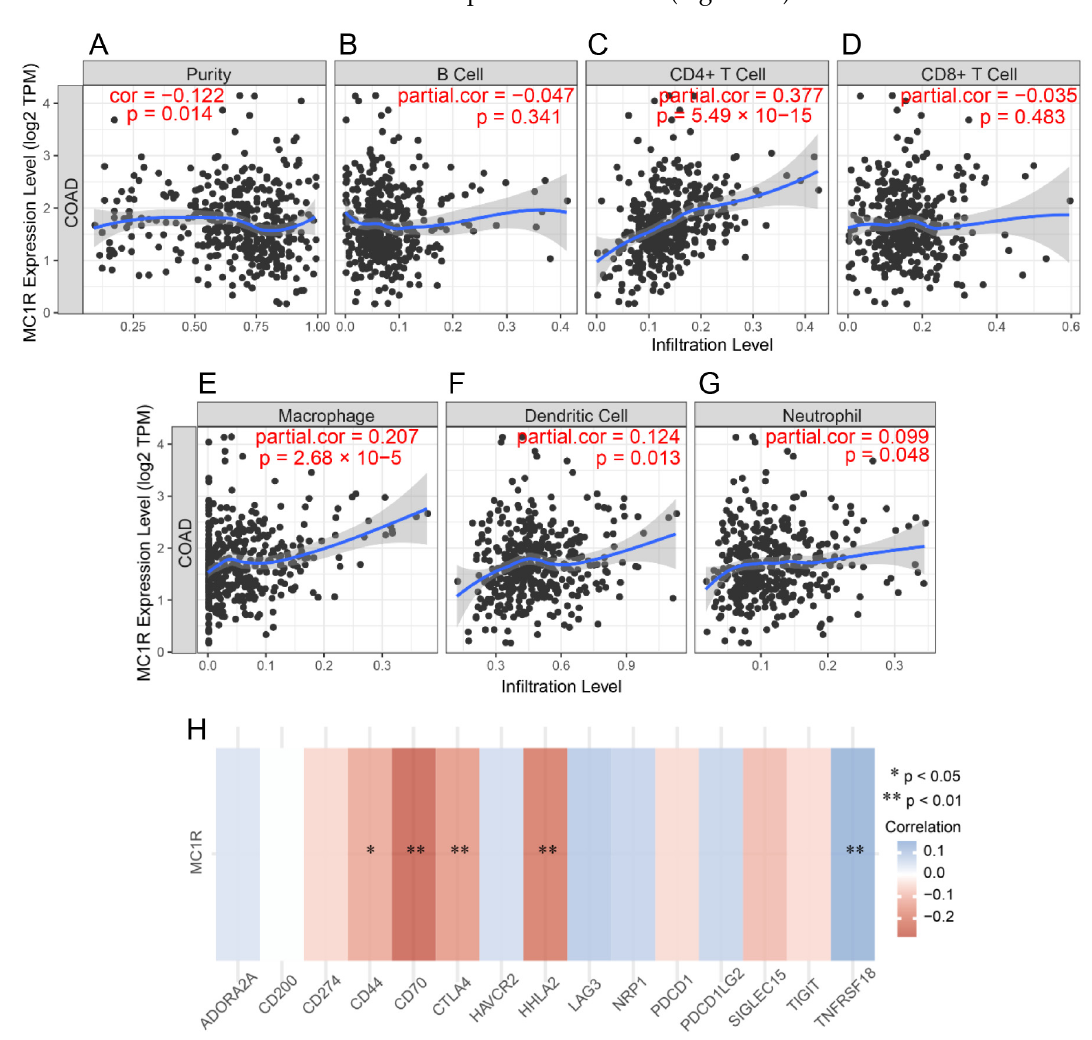
Figure 5. Immunological features related to MC1R in CRC. Correlation analysis of MC1R expression and infiltration of immune cells in CRC in the TCGA cohort. ( A ) Tumor purity, ( B ) B cells, ( C ) CD4+ T cells, ( D ) CD8+ T cells, ( E ) macrophages, ( F ) neutrophils, and ( G ) dendritic cells relative to MC1R expression. ( H ) Correlation between MC1R expression and the expression of 15 immune checkpoint